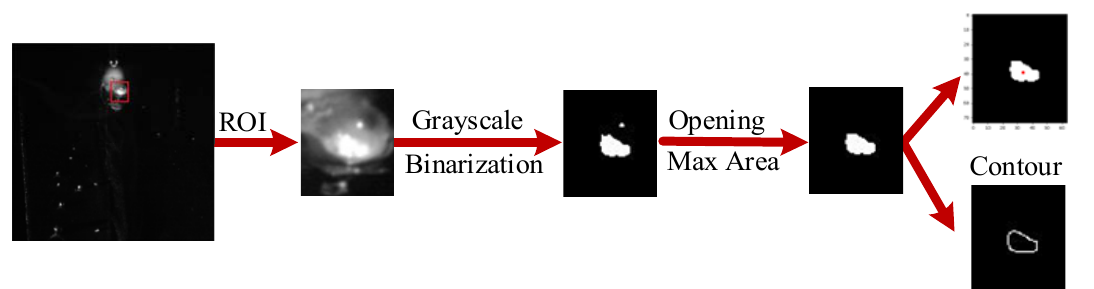
Figure 3. Image process of keyhole features extraction.